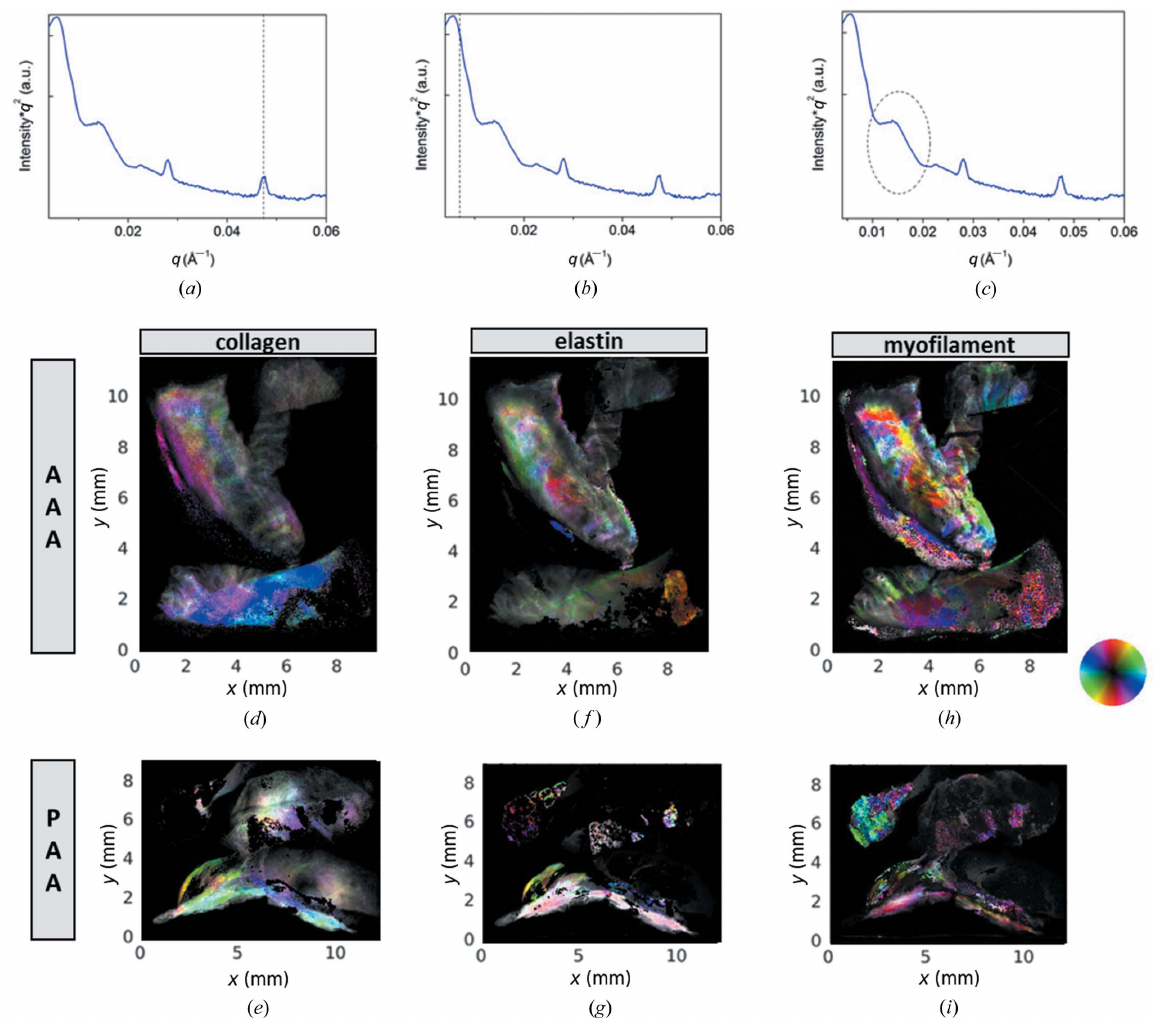
Figure 5 SAXS images. In ( a ), ( b ) and ( c ) identical SAXS profiles are shown, highlighting with markers diffraction peaks of filaments: ( a ) the fifth order of the (cid:2) 65 nm axial spacing of collagen type 1, ( b ) a distance attributed to the elastin fibril diameter and ( c ) the first order of the 38–43 nm axial spacing of myofilament. These filament SAXS signals were used in the multi modal analysis of the SAXS patterns; providing images of parameters related to abundance and SAXS orientation of collagen [( d ) and ( e )], elastin [( f ) and ( g )] and myofilament [( h ) and ( i )]. The peak amplitude and thus abundance is coded as brightness. The correspondence of color to orientation of the SAXS signal is indicated via the color disc. Top row abdominal aortic aneurysm (AAA), bottom row popliteal artery aneurysm